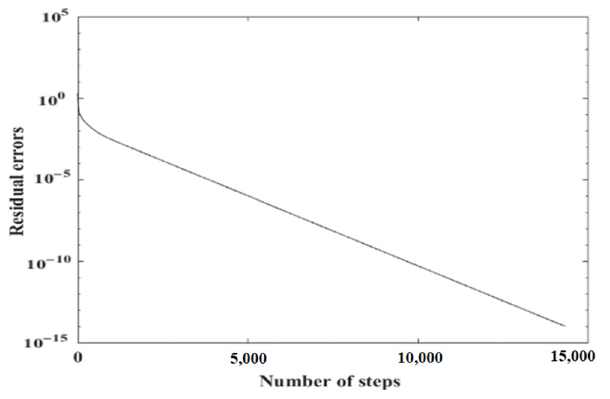
Figure 7. The convergence plot of Example 2.